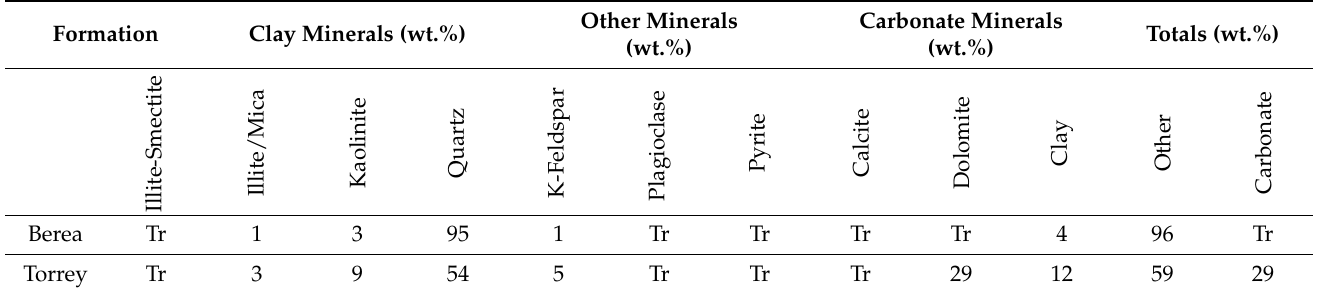
Table 2. X-ray diffraction analysis results. Tr ≤ 0.5%. Formation Clay Minerals